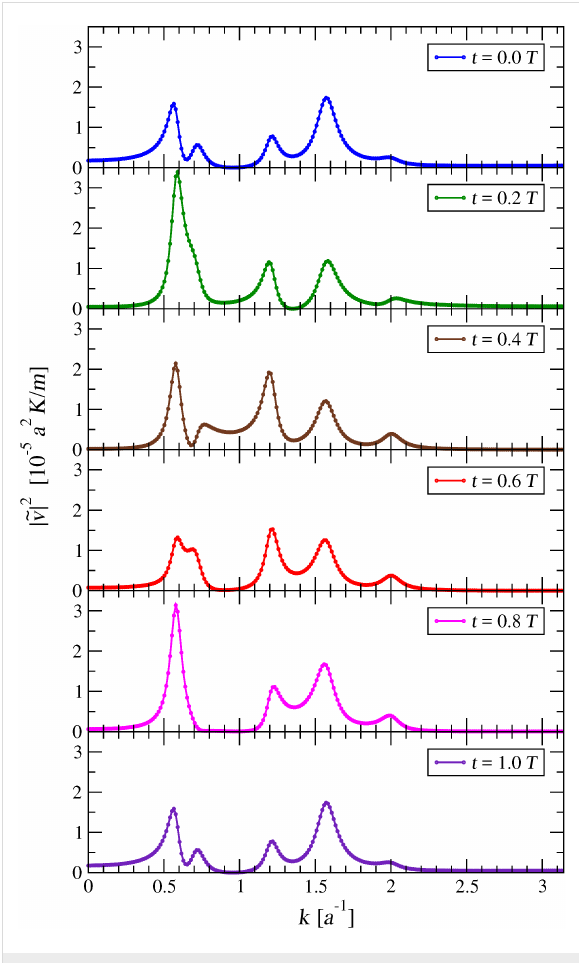
Figure 7: (a): A snapshot of the velocities of the chain particles while the slider, instantly at the vertical dashed-line position, advances at v SL = 0.1 v s . (b): The square modulus of the spatial Fourier transform ( k , t ) of the velocities, as defined in Equation 9. The peaks of the Fourier transform highlight the phonons most excited by the interaction with the slider at that given instant in time. For a given v SL , during the simulation the velocity pattern v j ( t ), and therefore its Fourier transform, evolve in time. We